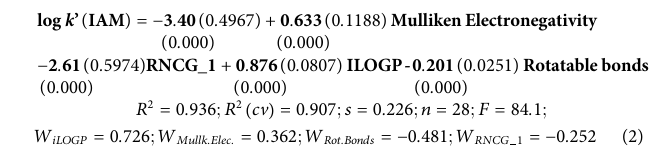
shows chromatographic